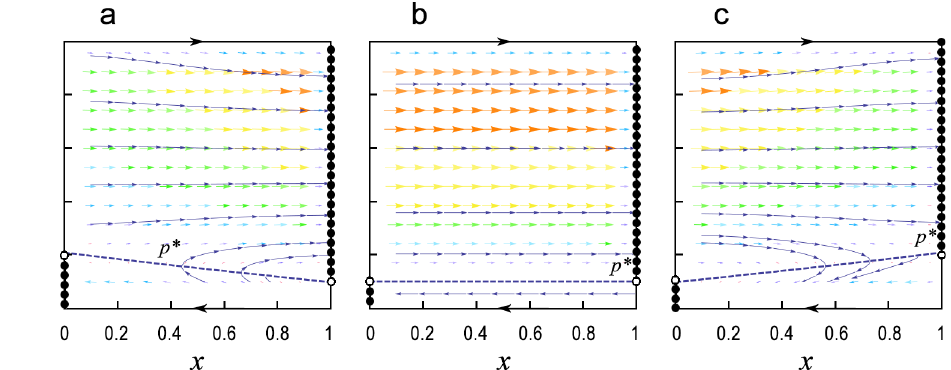
Fig 2. Phase portrait of the adaptive dynamics Eqs (1) and (2). For each of the three graphs, there is a curve p = p * ( x ) (the blue dash curve) separating the ( x , p )-plane such that dx / dt > 0 for p > p * ( x ) and dx / dt < 0 for p < p * ( x ). Stable equilibria and unstable equilibria of the adaptive dynamics are marked by solid dots and empty dots, respectively. Trajectories with large initial p converge to x = 1, and with small initial p converge